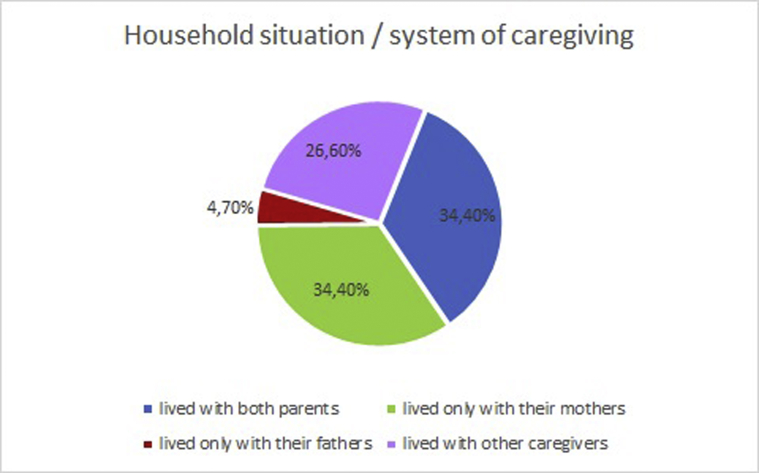
Household situation.